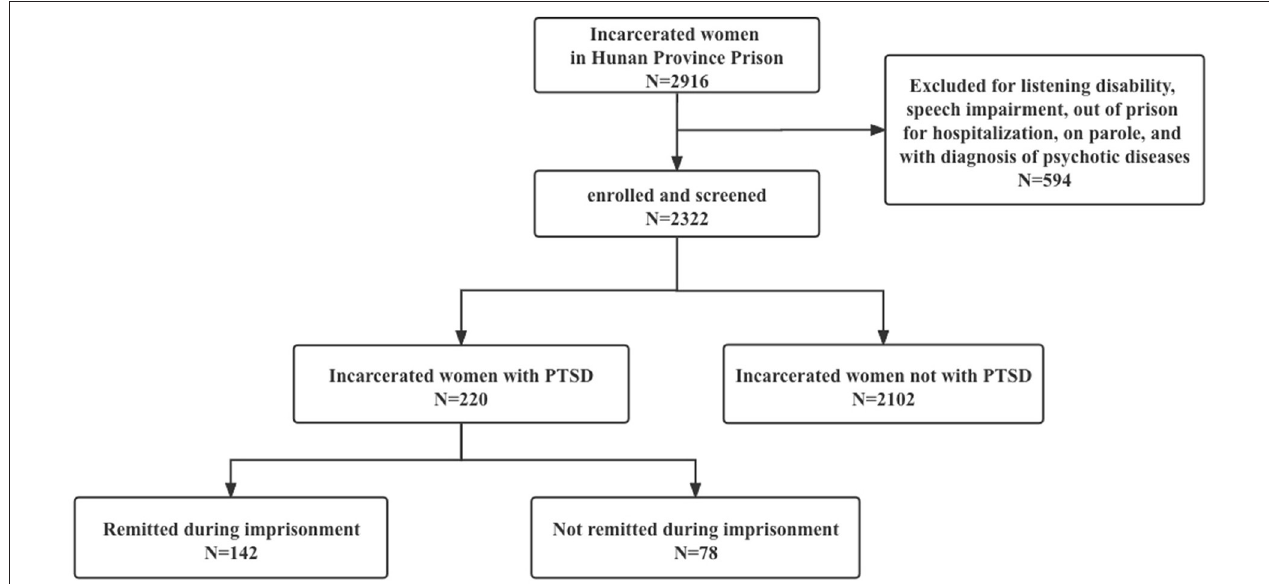
FIGURE 1 | Flow-chart of the study design. PTSD, post-traumatic stress disorder. reported a p -value < 0.1 in the univariate analyses were entered as the independent variables in the binary analysis, while the diagnosis of PTSD was set as the dependent variable. Finally, the multivariate binary logistic (Likelihood Ratio method) regression analyses were performed to explore the remission pattern of PTSD during imprisonment. Remission from PTSD was defined as the dependent variable and variables with a p -value < 0.1 in univariate analyses were set as the independent variables. Age and length of stay in prison was adjusted in the model. The statistical analyses were conducted using IBM SPSS version 26.0. Two- tailed p -values of 0.05 were considered as statistically